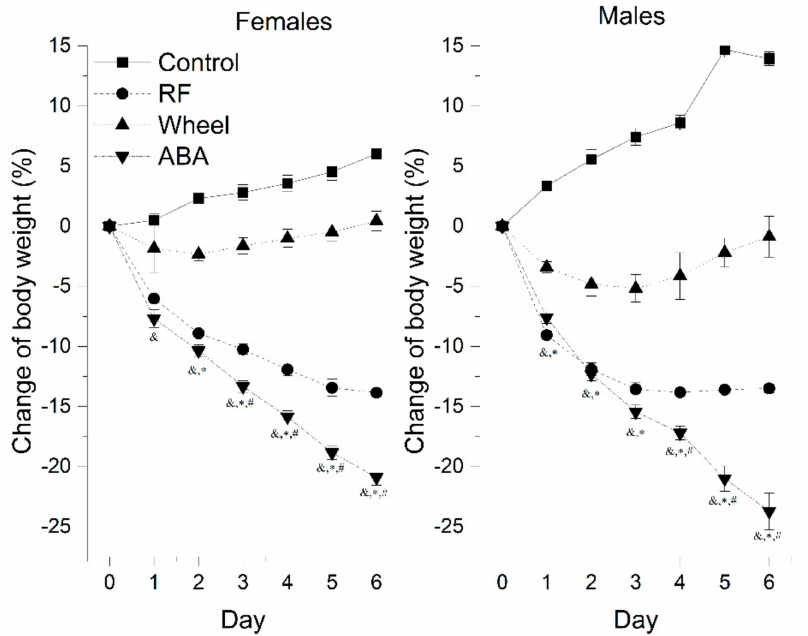
Figure 2. Body weight change in the all experimental groups of females ( n = 82) and males ( n = 20). Statistically significant difference marked as: & vs. C, # vs. RF, * vs.